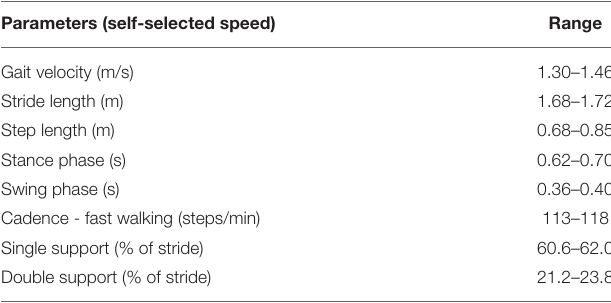
TABLE 3 | Typical gait parameters of an adult healthy population.